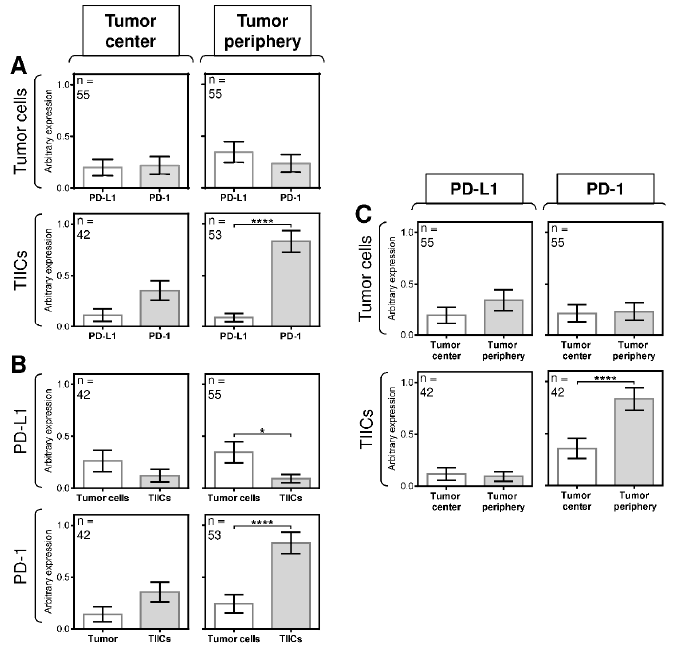
Figure 3. The differences between the expression of PD-L1 and PD-1 in tumor cells and TIICs are clustered in the tumor periphery. ( A ) The expression of PD-L1 and PD-1 differs between tumor cells and TIICs in the tumor center and tumor periphery. The number of patients ( n ) evaluated is shown in the top left corner of each panel. ( B ) The expression of PD-L1 and PD-1 differs between tumor cells and TIICs in the tumor center and tumor periphery. The number of patients ( n ) evaluated is shown in the top left corner of each panel. ( C ) The expression of PD-L1 and PD-1 differs between tumor cells and TIICs in the tumor center and tumor periphery. The number of patients ( n ) evaluated is shown in the top left corner of each panel. In ( A – C ), the difference between groups was evaluated with respect to the frequencies of the PD-1/PD-L1 expressions and their mean values and analyzed by the Mann–Whitney U test ( n is shown in the top left corner of each panel; * p < 0.05, ** p < 0.01, *** p < 0.001, **** p < 0.0001). The data are shown as the mean ± SEM, and the arbitrary expression level corresponds to the scoring system described in the Materials and Methods